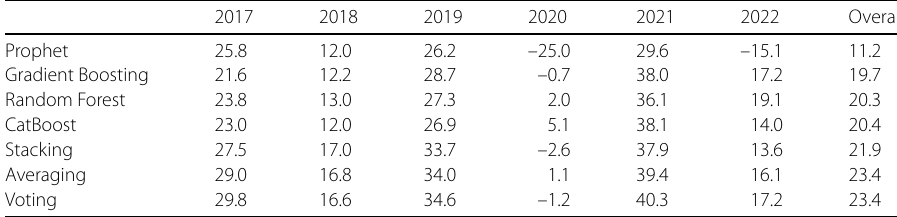
Table 9 Percentage improvement of proposed models over the benchmark for Clinic 2 across all years